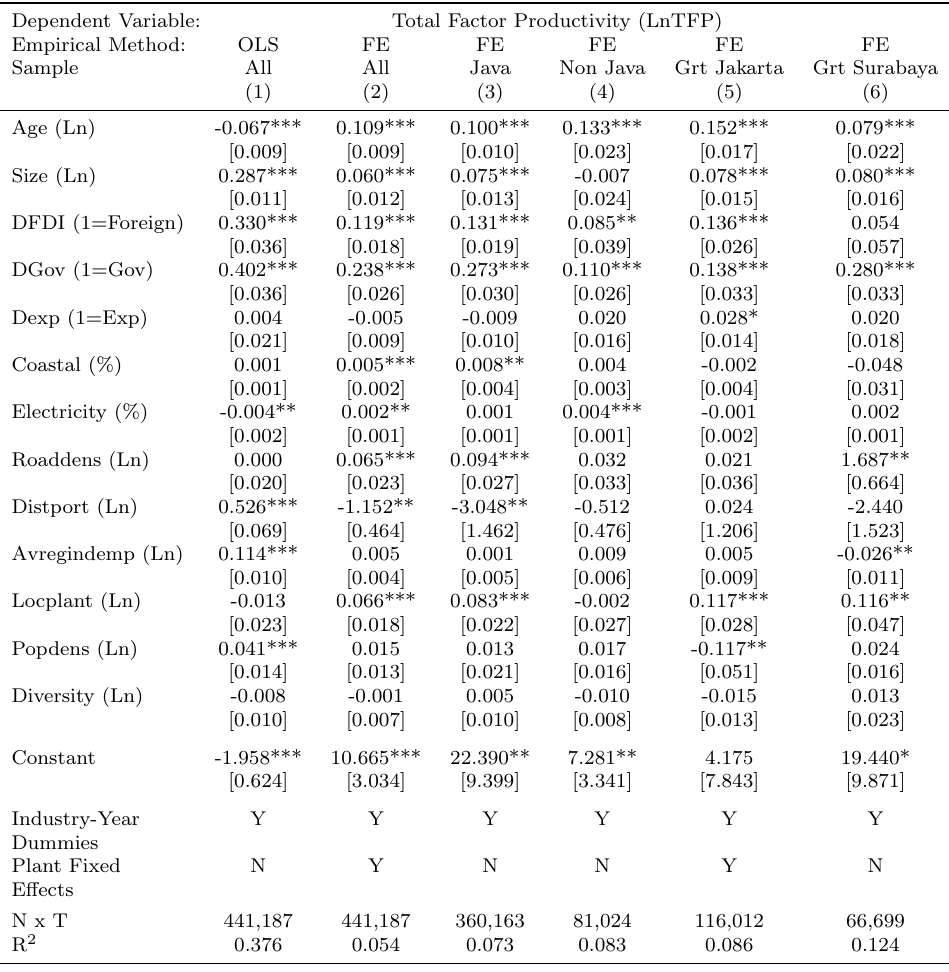
Table 2: Agglomeration Externalities: Main